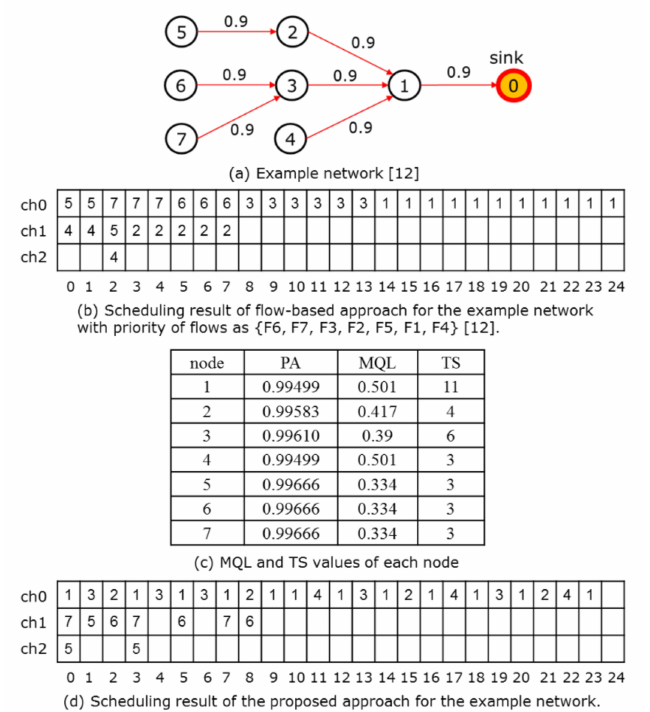
Figure 4. Scheduling results of the proposed algorithm and flow-based algorithm on the example network with